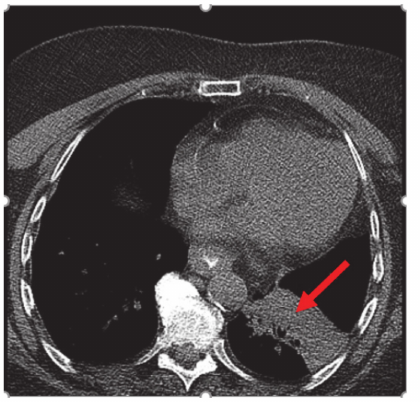
Figure 1. CT chest: left lower lobe consolidation / atelectasis (red arrow) with obscuration of proximal left lower lobe bronchus and mildly enlarged mediastinal